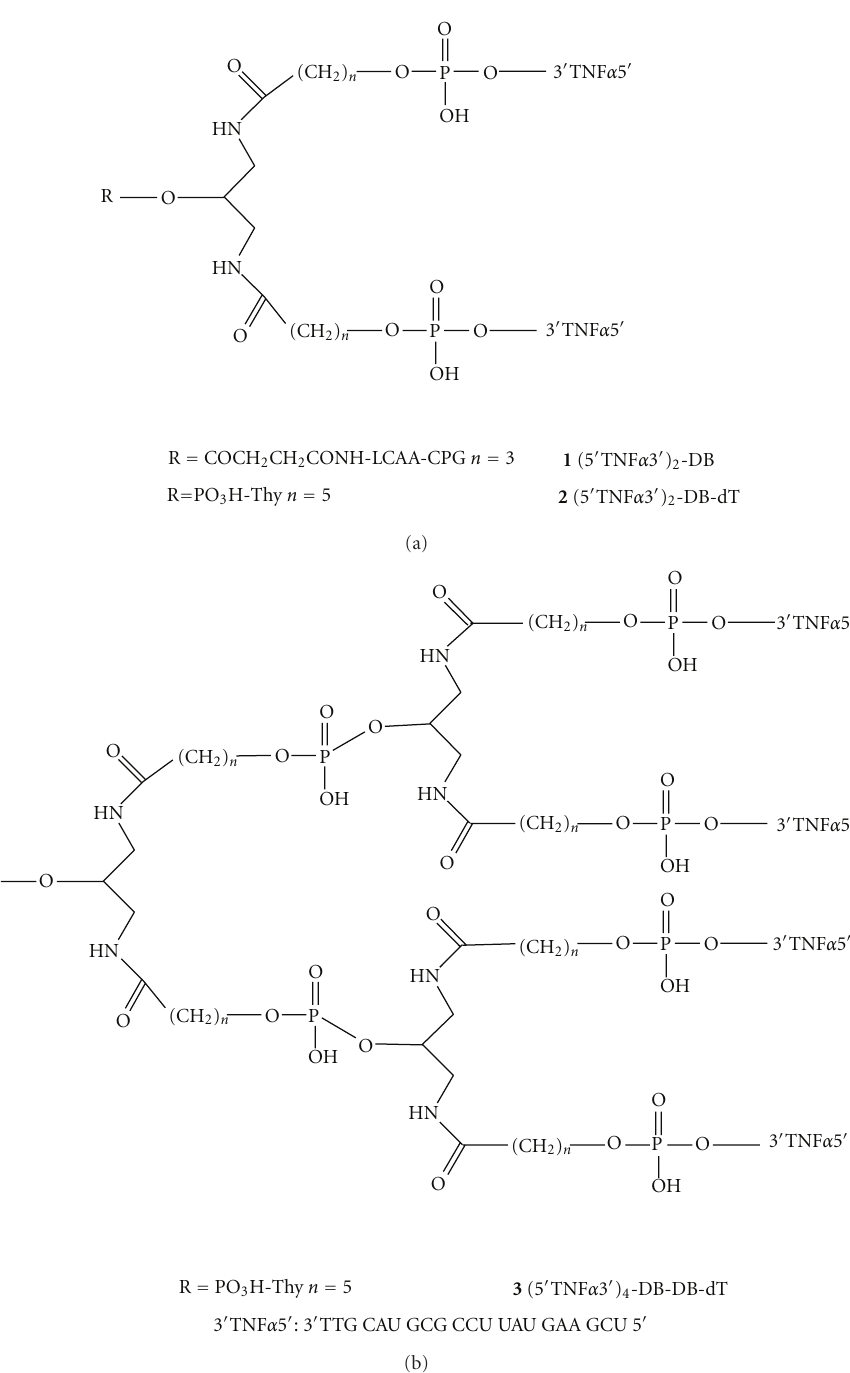
Figure 2: Schematic representation of the chemical structure of the branching units of the oligonucleotides described in this study.